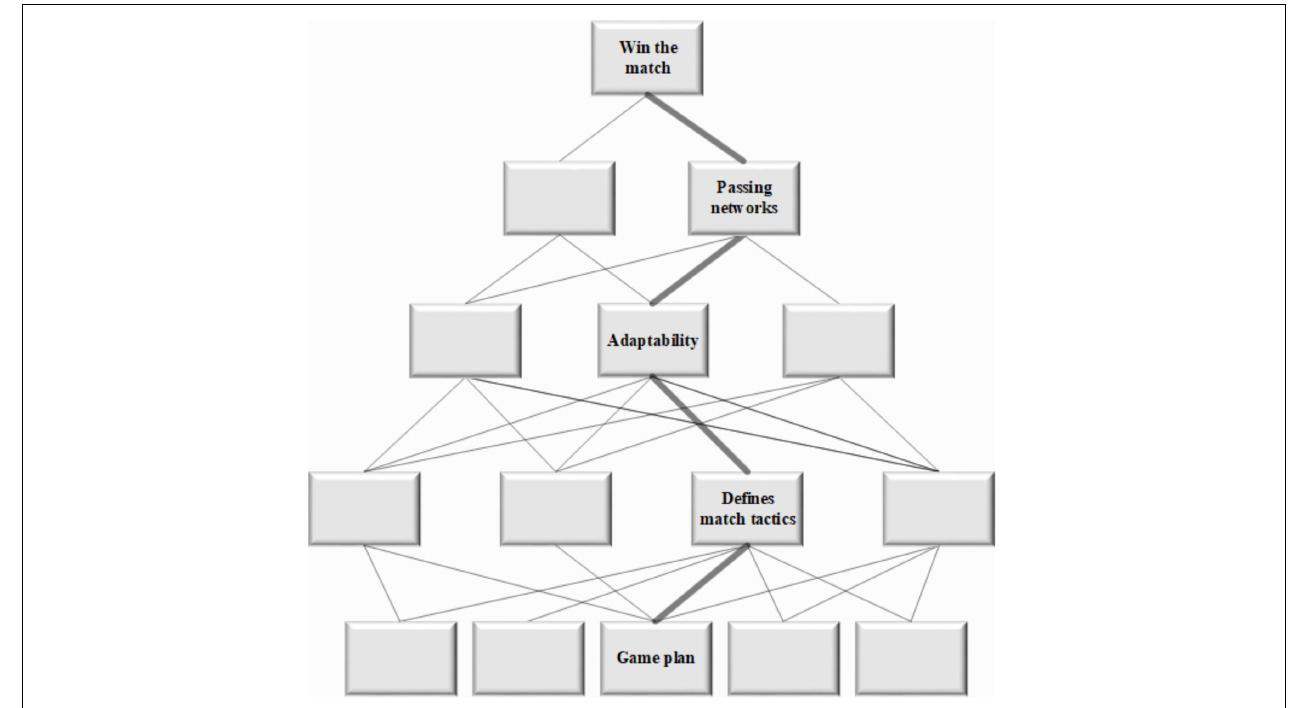
FIGURE 2 | Example means-end-links pathway. The relationship between levels of the abstraction hierarchy are indicated by the means-end-links using a how-what-why triad. Working from bottom to top, the physical object ‘Game plan,’ enables the object related process of ‘Define match tactics,’ which includes the purpose related function of ‘Adaptability’ of which can be assessed by the ‘Passing networks’ which can be measured to determine its influence on the functional purpose ‘Win the match.’ This approach is completed for all components in the developed netball performance system